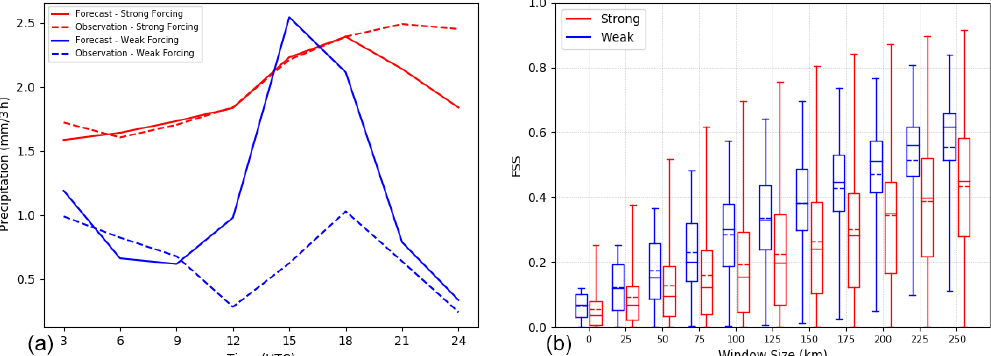
Figure 14. (a) Aggregated diurnal cycle of 3-hourly precipitation values corresponding to the 95th percentile, both stratified in weakly (blue) and strongly forced weather regimes (red) and averaged over the full SOP1 period. (b) FSS of 95th percentile of 3-hourly precipitation as a function of neighbourhood size conditional on weather regime averaged for the entire HyMeX-SOP1 between 12:00 and